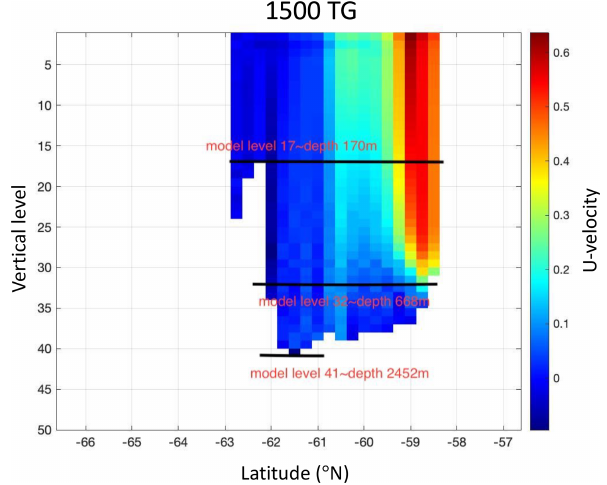
Figure F1. Hydrographic sections of the zonal velocities through the 1500m TG. The vertical level is the uneven model level. Black lines show some unique levels and the corresponding